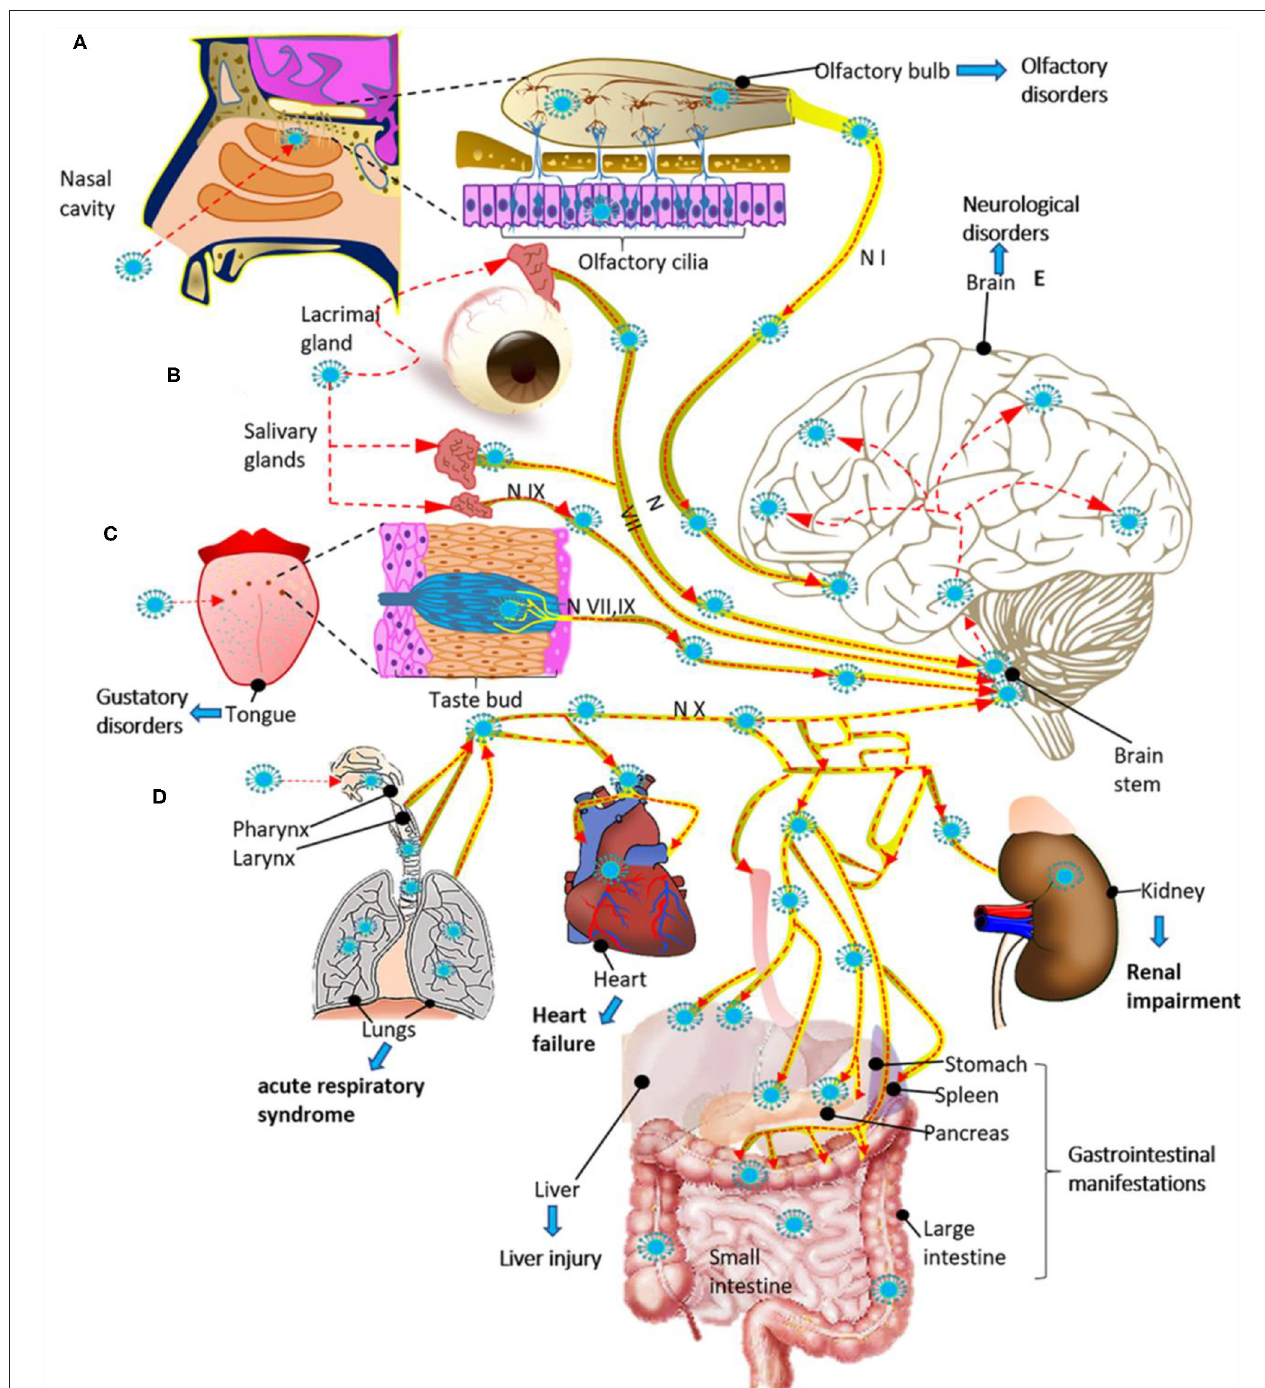
FIGURE 3 | Potential routes for infection and spread of SARS-CoV-2 to systemic organs and the central nervous system through the cranial nerves (N). (A) SARS-CoV-2 could enter through the olfactory mucosa (causing anosmia), spread through the olfactory nerve (N I) and end in the olfactory cortex. (B) SARS-CoV-2 could also enter through the lacrimal and salivary glands, spread through the facial (N VII) and glossopharyngeal (N IX) nerves, and end in their respective brain stem nuclei. (C) The infection could spread from the taste buds (triggering ageusia) through the N VII and N IX nerves ending in the NTS located in the brain stem. (D) SARS-CoV-2 could also enter through the respiratory tract, reach the respiratory system and via the vagus nerve (N X), spread to other systemic organs innervated by this nerve, and end in the brain stem. (E) Finally, once the virus reaches the brain stem, it can spread to the brain through neuroanatomically interconnected pathways. The SARS-Cov2 infection can cause multiple organ dysfunction syndrome (A–E) . The red dashed arrows indicate the possible dissemination route for SARS-CoV-2 through the cranial nerves.